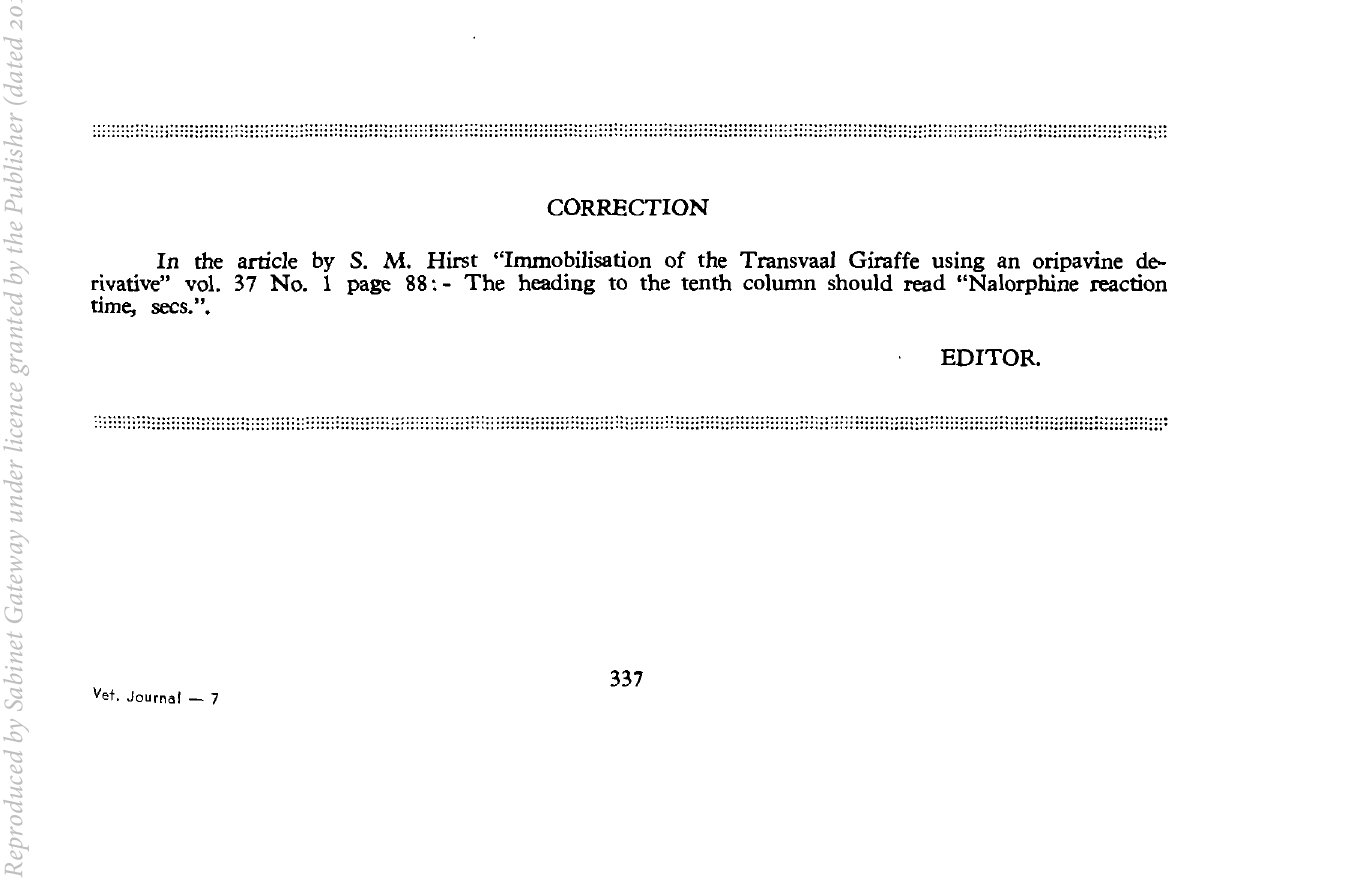
(a) HENRICI, M. G. A. (1947). Botanical survey in connection with enzootic icterus. Rept. to Dir. Vet. Servo Onderstepoort. (b) HENRICI, M. G. A. (1947). Mariasdal: Mr. Hunter. Rept. to Dir. Vet. Servo Onderstepoort. (c) HUGO, W. J. (1959). Ondersoek na ensootiese ikterus in die Fraserburg distrik: 14 en 15 Oktober 1959. Rept. to Secretary, Agric. Tech. Servo